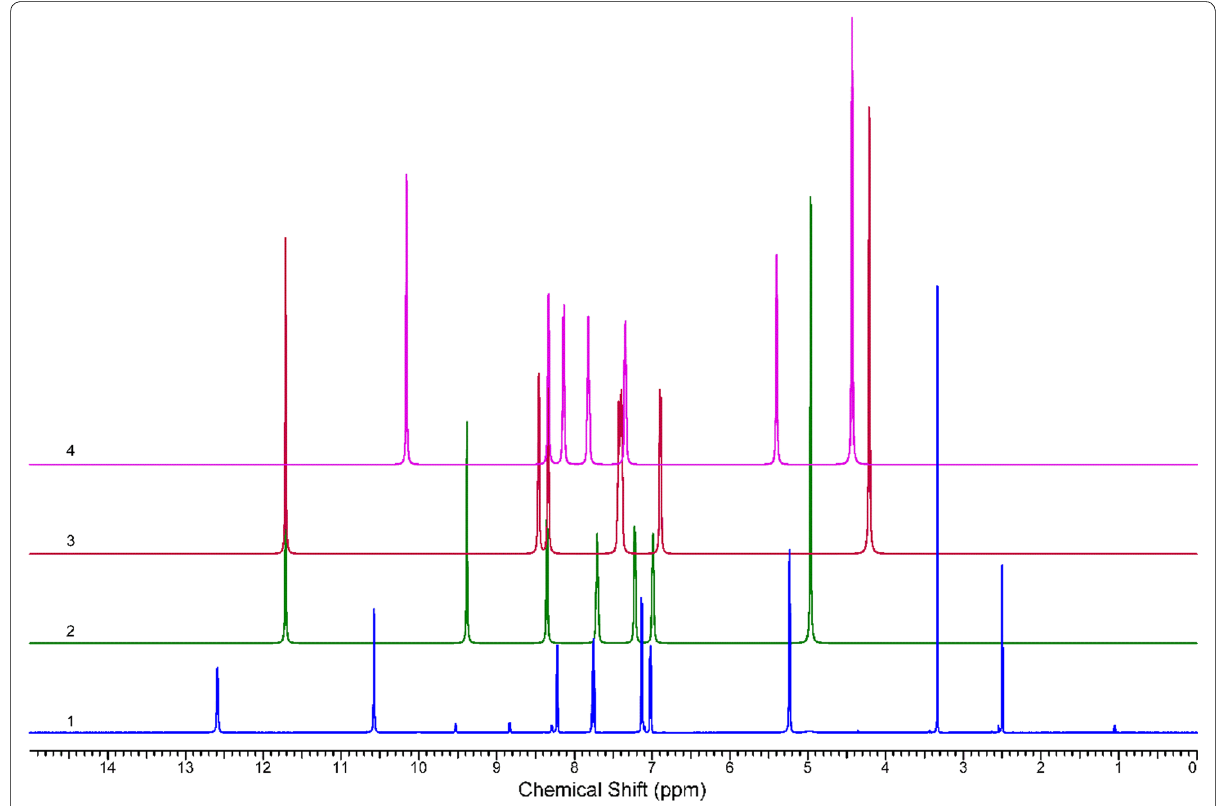
Fig. 3 1H NMR of (1) Experimental (2) form (A) (3) form (B) (4) form (C) of N